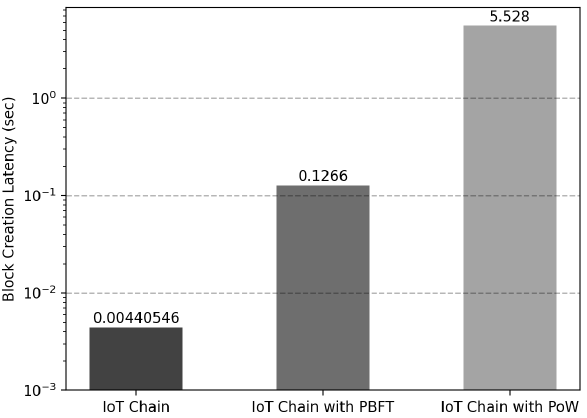
Figure 11. Latency comparison according to IoT-Chain consensus algorithm.